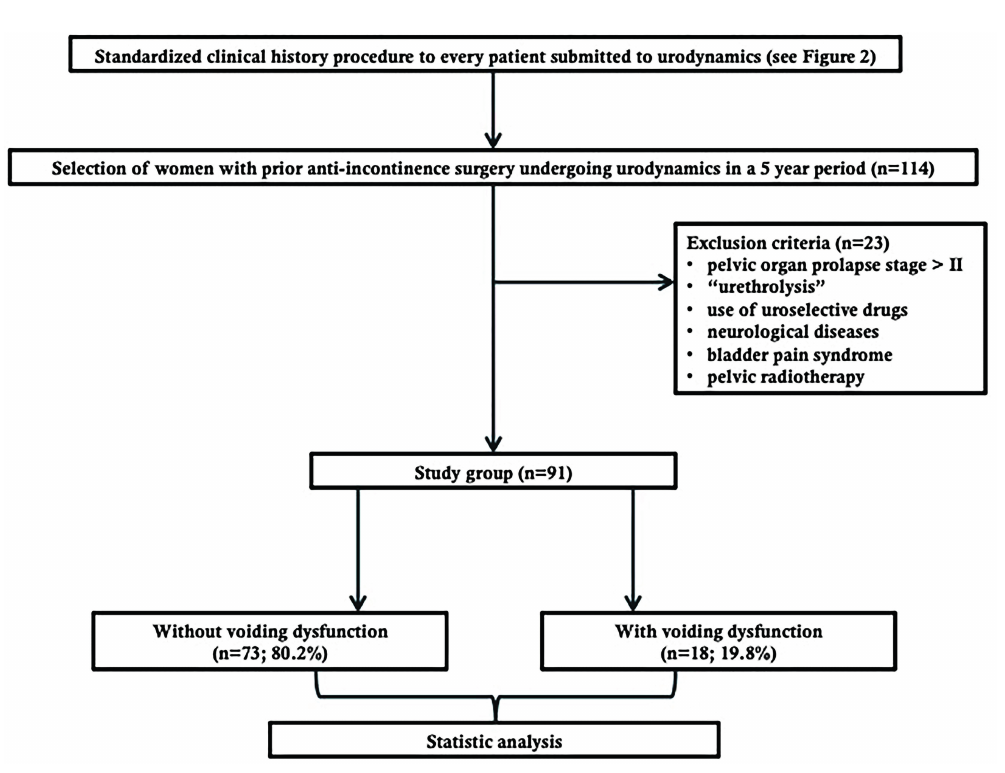
Figure 1 - Flowchart of “Material and